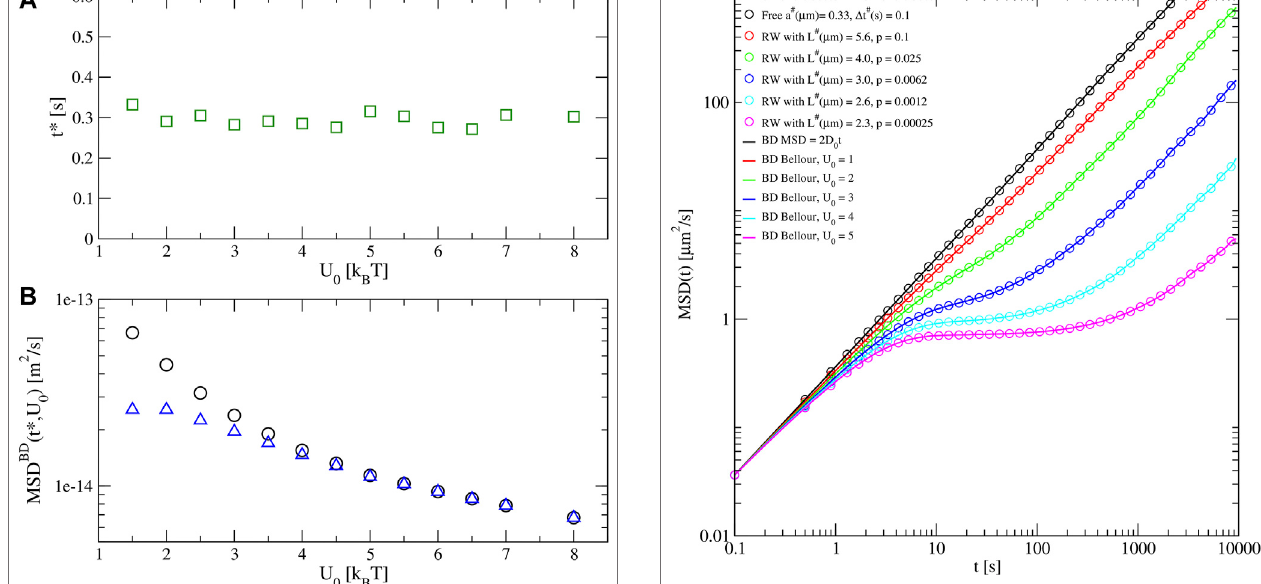
FIGURE 9 | (Color online): (A) Critical time t p at which a change of curvature in the MSD is observed (green squares), and (B) mean square displacement at the critical time MSD ( t * ) as a function of the maximum height barrier U 0 (black circles). The blue triangles are associated the Bellour fi ttingparameter2 δ 2 BD displayedin Table1 .Thesevalueswereobtainedfrom Brownian dynamics simulations in which L (cid:2) 1 . 0 × 10 − 6 m and D 0 (cid:2) 1 . 8 × 10 − 13 m 2 / s in all cases.